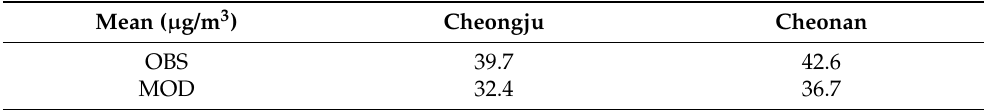
Table 8. Observed and simulated monthly mean PM 2.5 at Cheongju station in Chungbuk province and Cheonan station in Chungnam province.